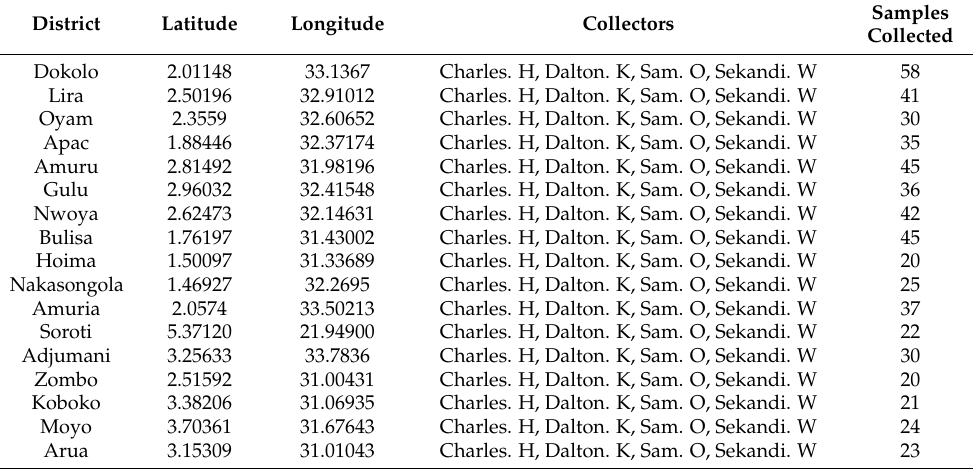
Table 1. Ugandan districts from which the samples were picked, GPS coordinates for each district and the total number of samples picked per